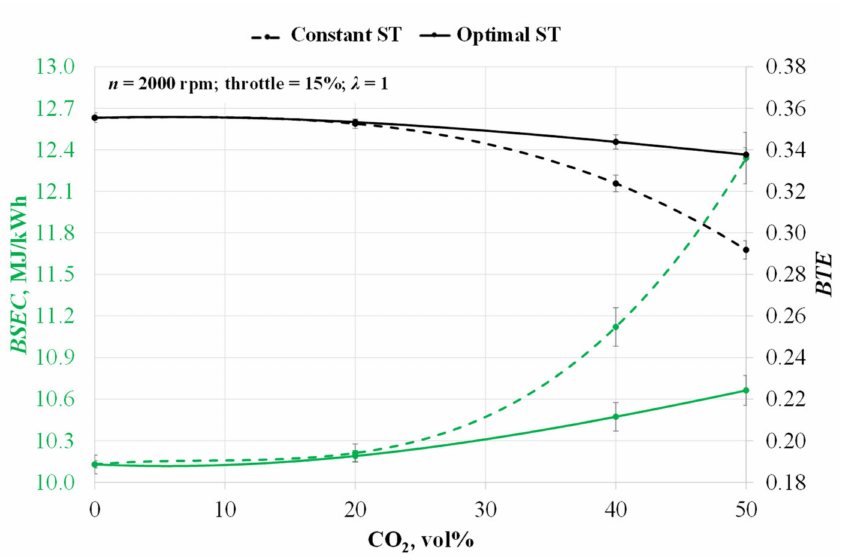
Figure 3. Change of the brake-specific energy consumption and brake thermal efficiency depending on the volumetric fraction of CO 2